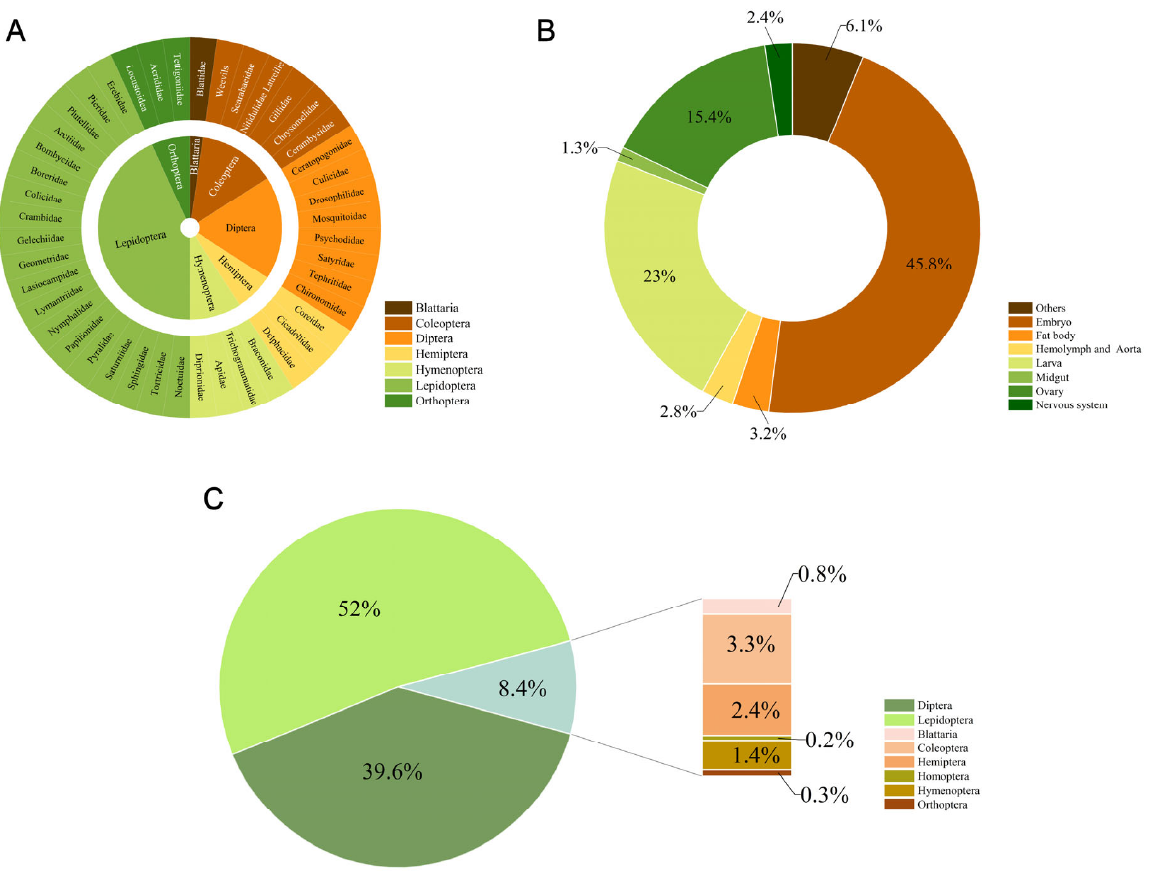
Figure 1. The statistics of established insect cell lines. A : The main order and family source of current established insect cell lines. B : The proportion of different tissues contributing to established insect cell lines. C : The proportion of different orders contributing to established insect cell lines.